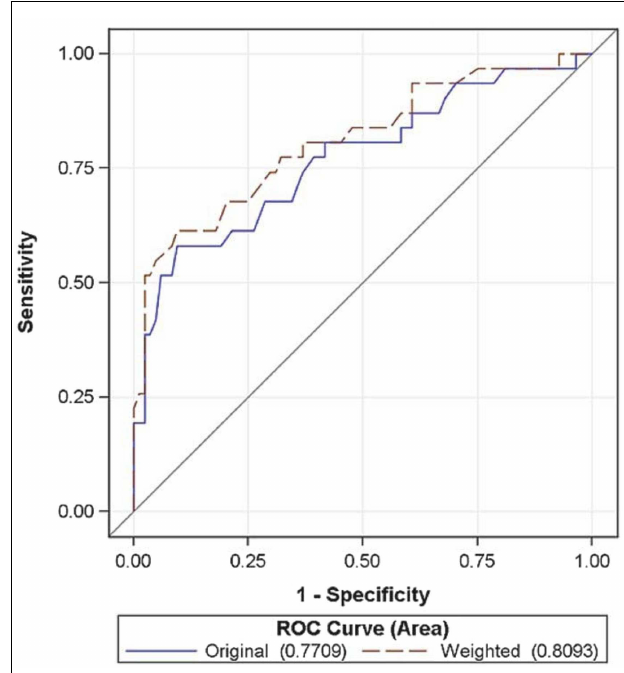
FIGURE 1 | ROC curves for